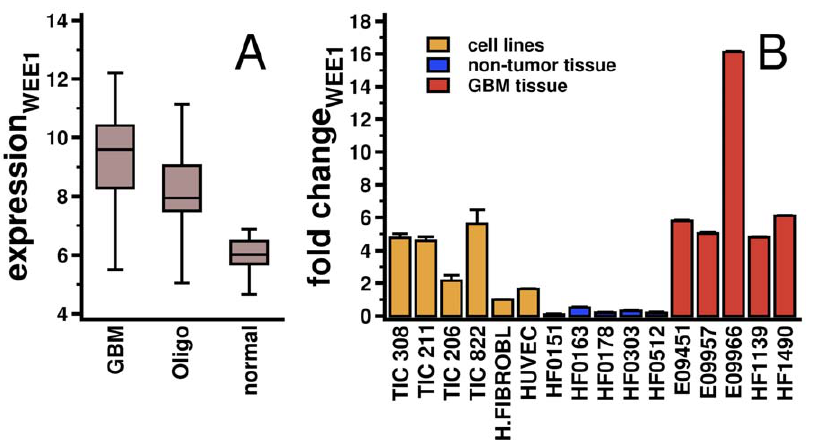
Figure 4. Expression patterns of WEE1. ( A WEE1 is over-expressed in GBMs and Oligodendrogliomas. ( B ) Expression of WEE1 was validated by quantitative reverse transcription polymerase reaction (RT-qPCR) in five representative GBM tumor samples that belong to the GA subtype, five non- tumor samples, four tumor initiating/stem cell lines (TICs) and two unperturbed cell lines (human fibroblasts and HUVEC). We observed that TIC 308 showed an average WEE1 fold change that was similar to the corresponding averages in the GBM samples.